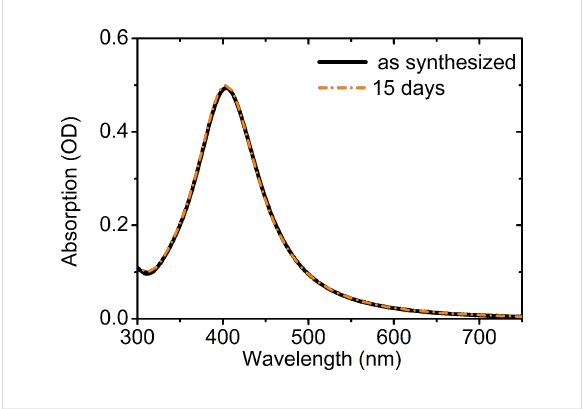
eter using about thirty nanoparticles with a resulting value of 2.5 ± 0.3 nm.